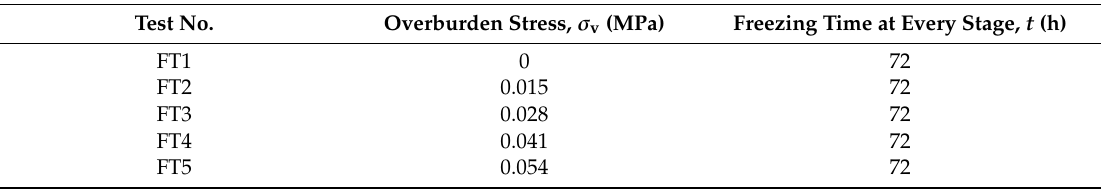
Table 1. Experimental conditions.